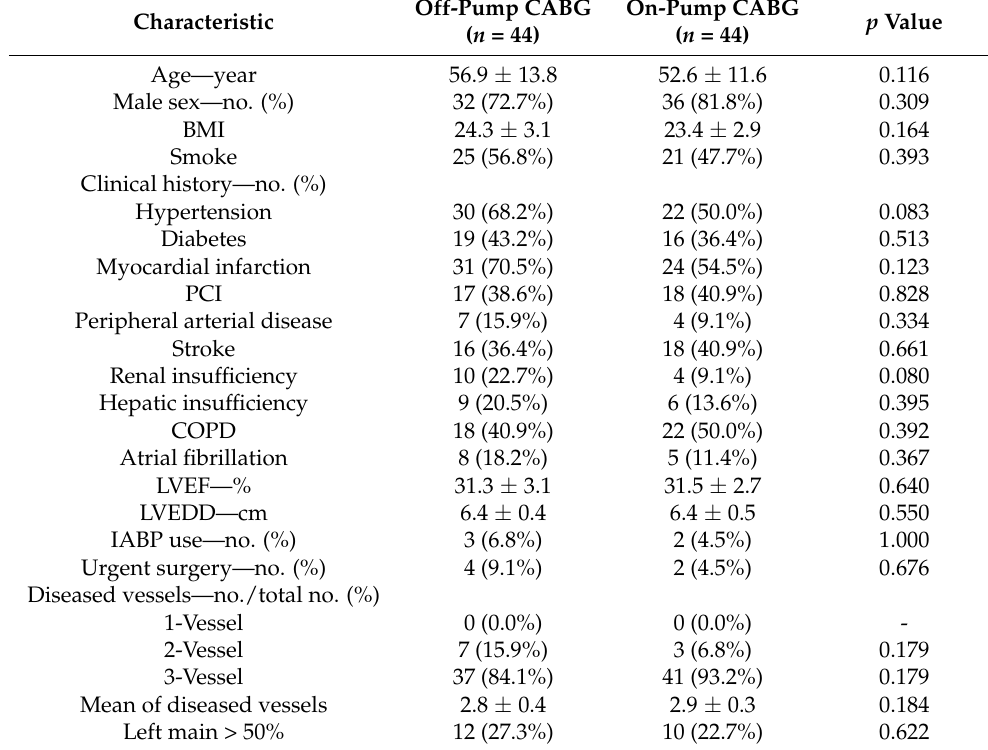
Table 2. Baseline characteristics of the patients after